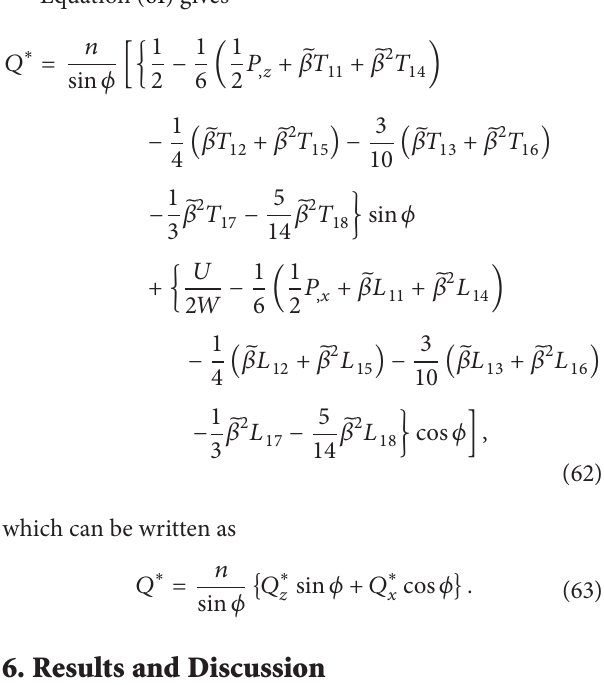
where 𝑄 ∗ = 𝑄/𝑊ℎ𝐵 and 𝑛 is the number of parallel flights in a multiflight screw.